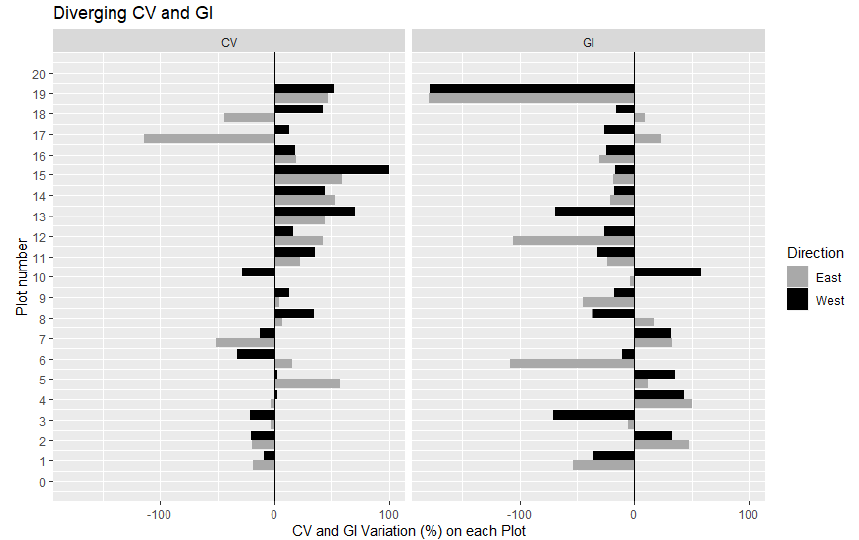
Figure A4. When measuring Vegetation Cover and Grass Infestation by a 25-m line shapefile, which is a simulation of the traditional fieldwork procedure, these FR structural parameters significantly varied when moving the measuring line 2 m in east and west directions. The registered Error Percentage presented mean and standard deviation equal to 11.48 ± 39.45 for Vegetation Cover and − 20.3 ± 54.61 for Grass